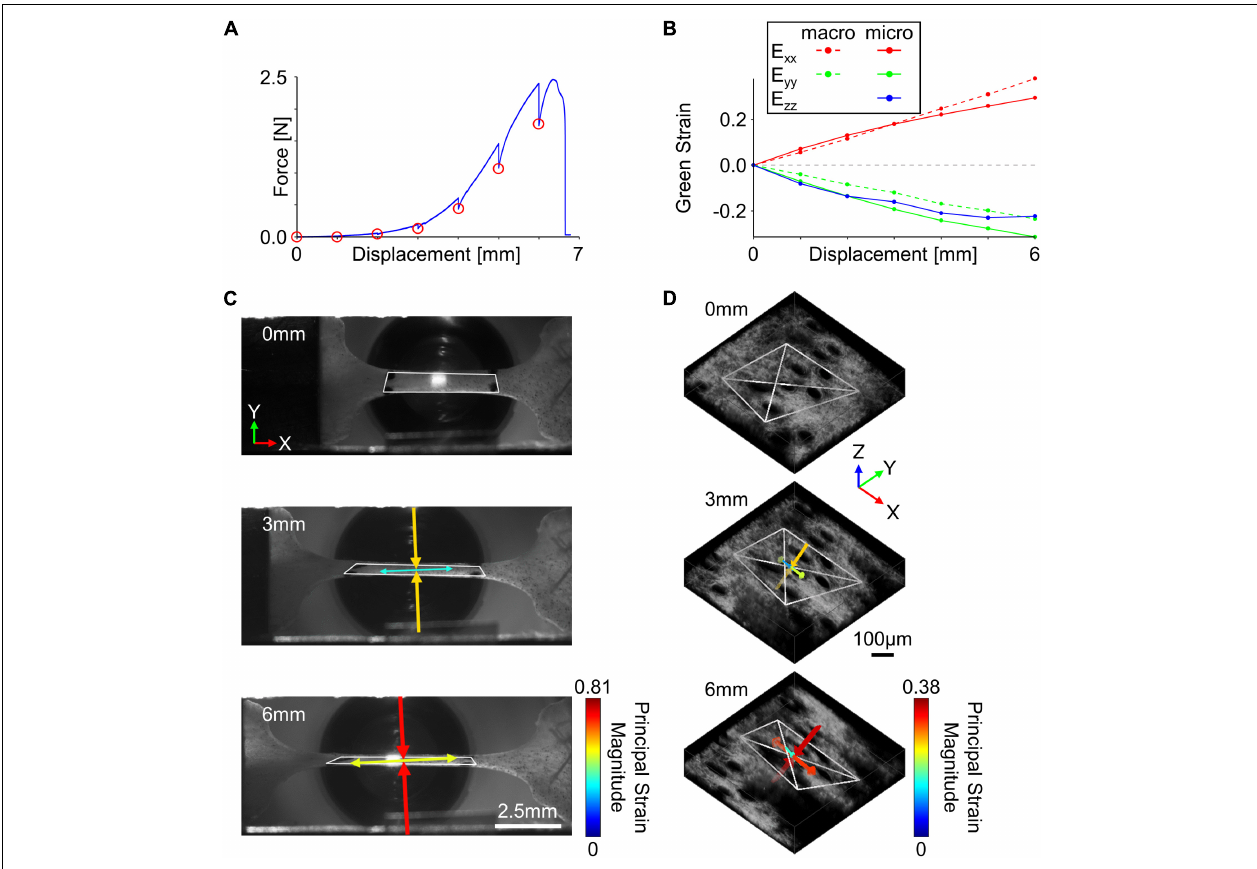
FIGURE 2 | Tissue kinematics were quantified at multiple length scales during incremental stretching of skin in the x-direction. (A) To enable the collection of high-resolution micro-scale SHG image volumes, the skin was stretched in 1 mm increments (red circles) until mechanical failure. (B) Tissue kinematics were restricted to 2D at the macro-scale but were quantified in 3D at the micro-scale. (C) Macro-scale tissue deformation measured from fiduciary markers showed a substantial compressive principal strain orthogonal to the direction of stretch (scale bar represents 2.5 mm). (D) 3D micro-scale tissue kinematics measured from SHG features indicated compressive principal strains were occurring in both directions orthogonal to the loading direction (scale bar represents 100 µ m). For panels (C,D) , white polygons indicate tracked features, and arrows represent the direction and magnitude of principal